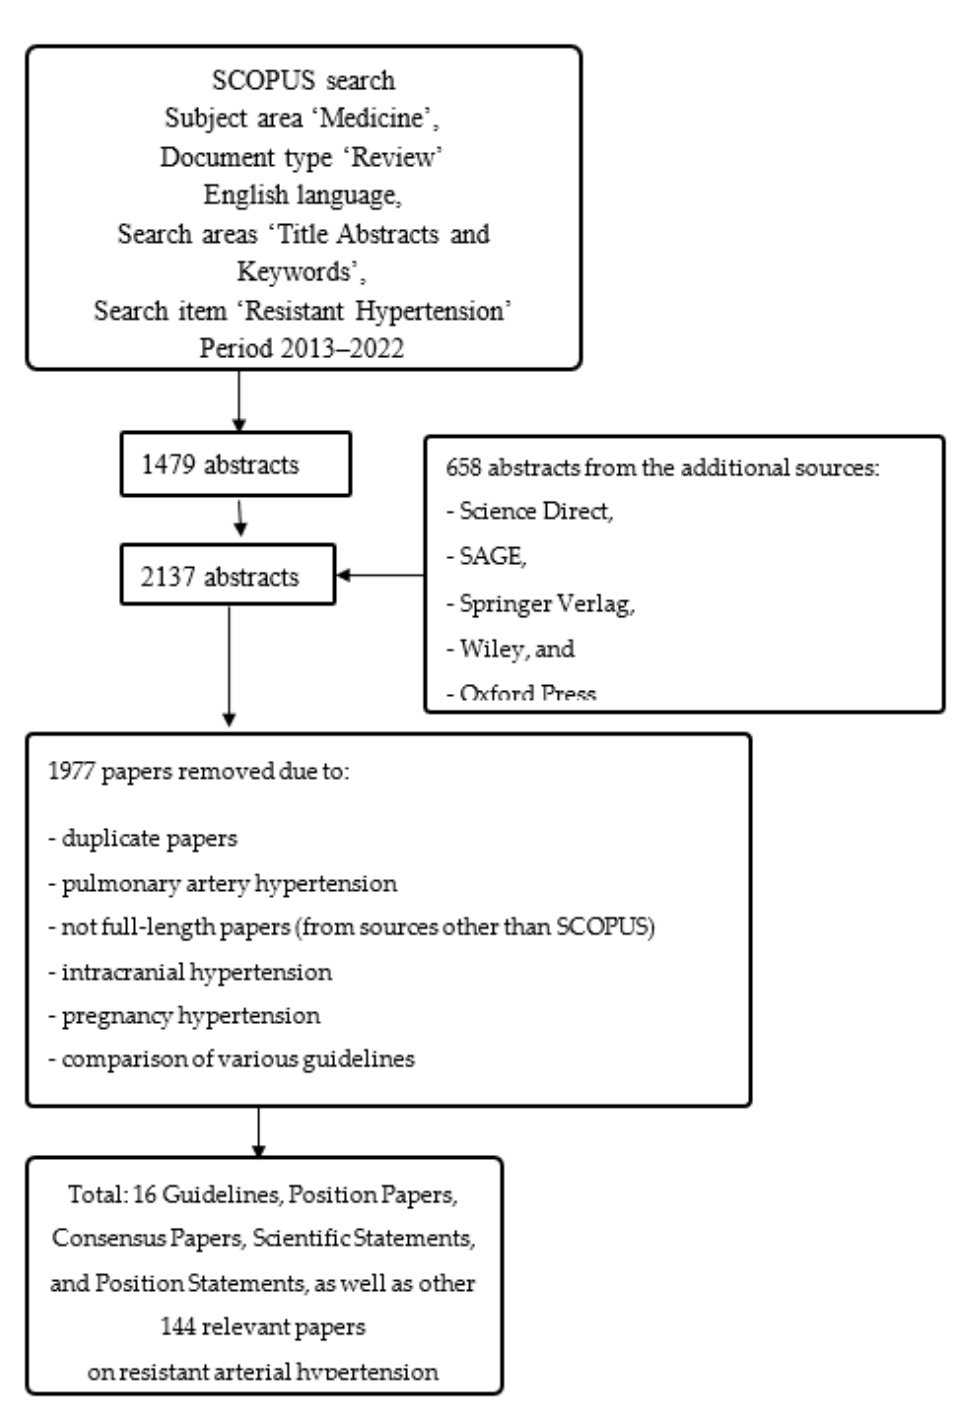
Figure 1. A flow chart for the search for resistant HTN, mostly in HTN guidelines. We performed a narrative review aiming to analyze the differences and shortcomings in the available papers, mostly using guidelines.